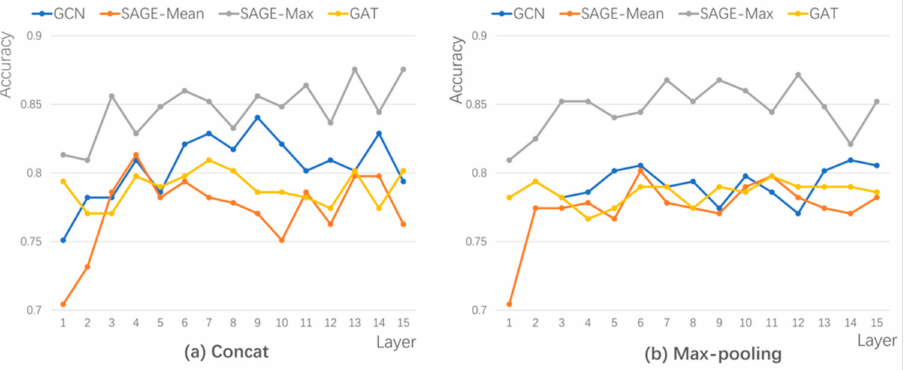
Figure 1. Comparison of the JK-Net architecture of ( a ) Concat and ( b ) Max-pooling, representing the accuracy of different